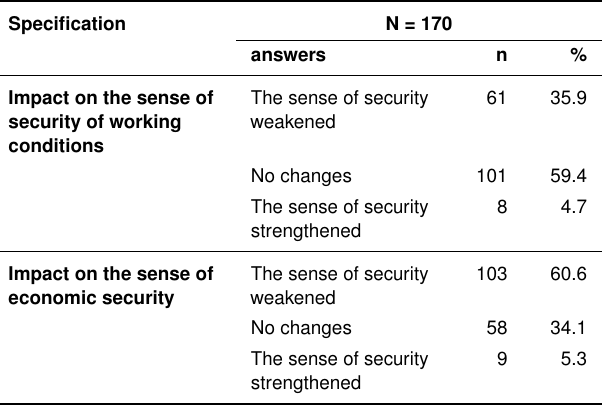
Table 4. The impact of the COVID-19 pandemic on the employees’ sense of security (N =